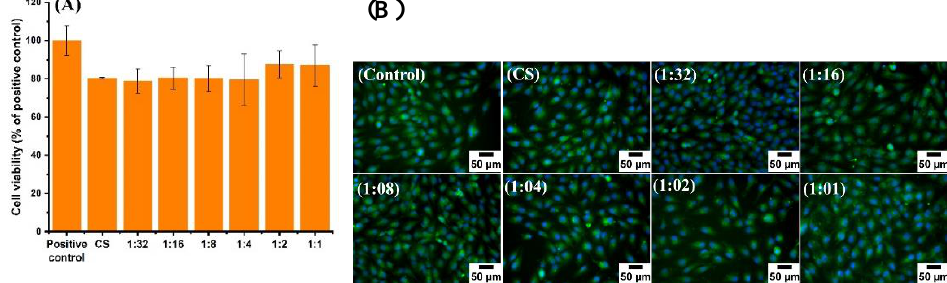
Figure 7. ( A ) Cell viability and ( B ) fluorescence microscope images of MG-63 cells cultured with the extracts of CS and Ga (III)-CS complexes for 24 h. The tissue culture plate was used as a control.